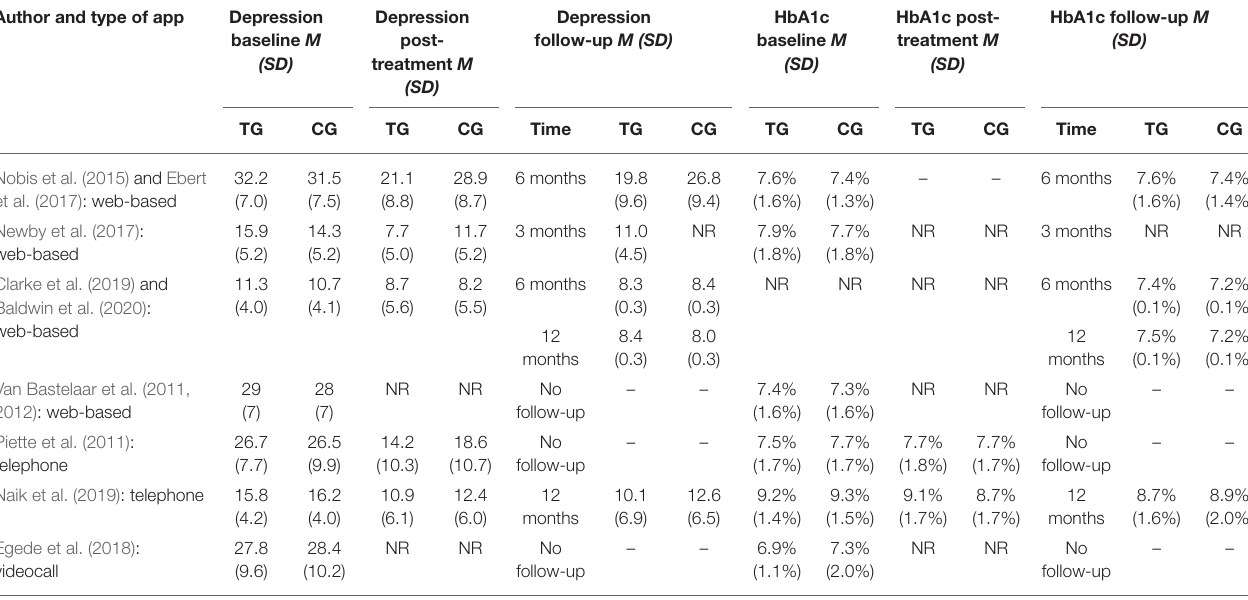
TABLE 3 | Results of depression and HbA1c baseline, post-treatment, and follow-up. Author and type of